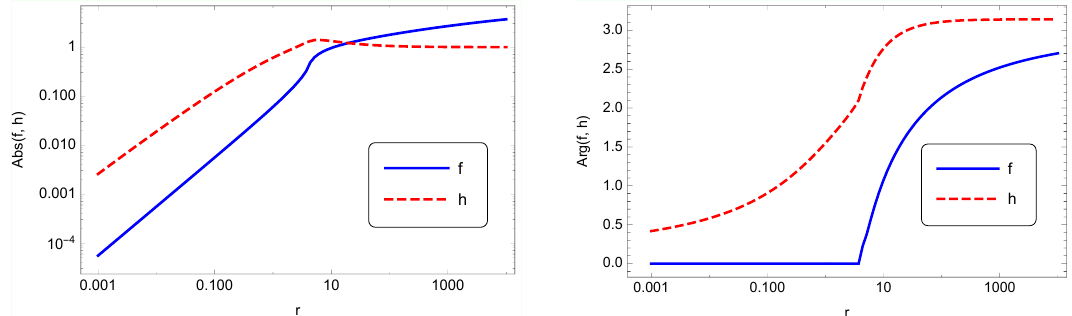
Figure 2 . Numerical values of the functions f ( r ) and h ( r ) in eq. (2.8) with r (cid:17) m 2